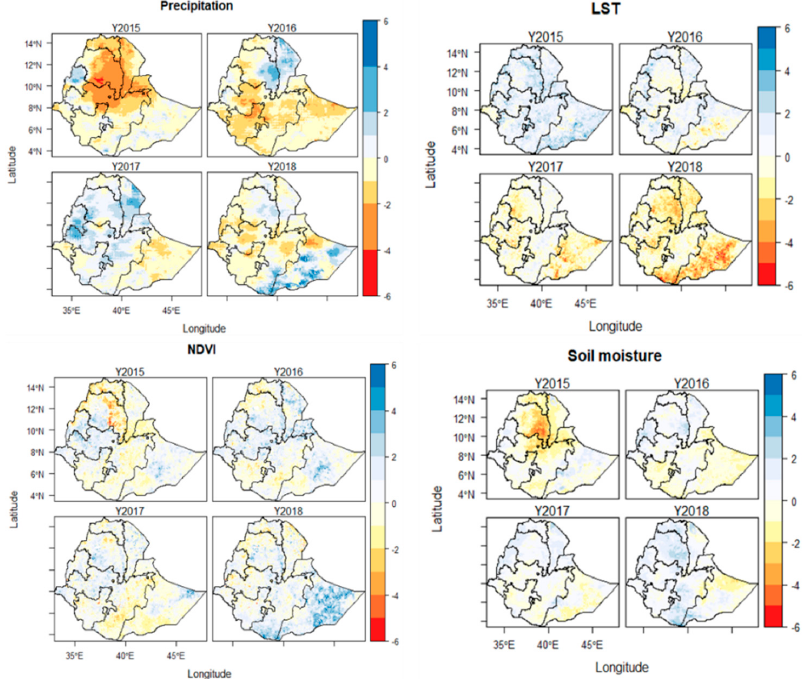
Figure 4. Standardized seasonal precipitation, LST, NDVI, and soil moisture anomalies from the 2001– 2014 climatology averaged over June–September.